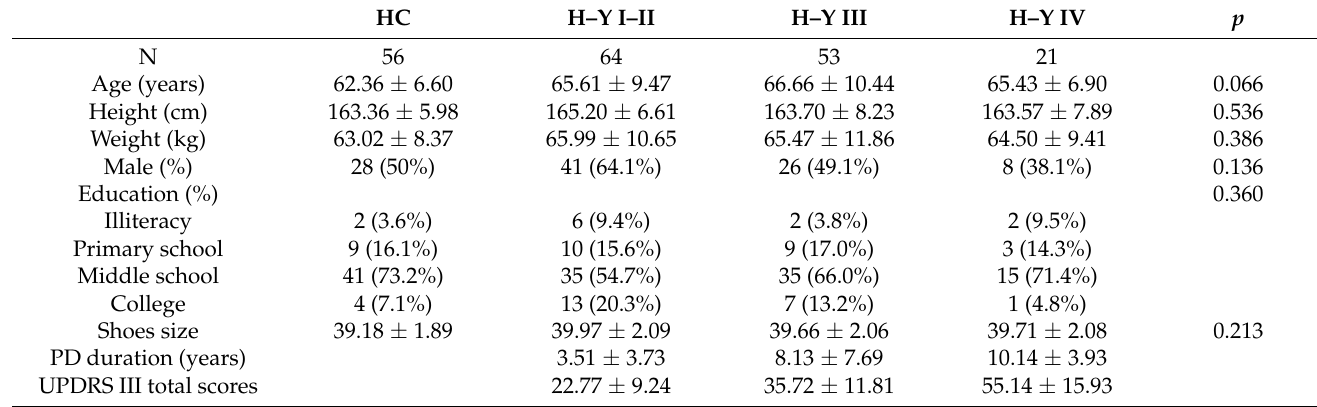
Table 1. Clinical baseline data of